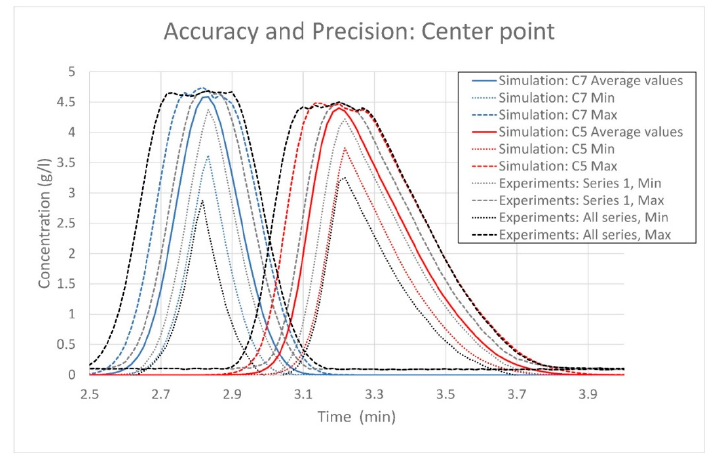
Figure 9. Comparison between simulations and experiments. Blue lines represent cycloheptanone, red lines represent cyclopentanone, and black/grey lines represent simulations. Solid lines are simulations with all variables at default. Dotted lines are minimum values, dashed lines are maximum values.